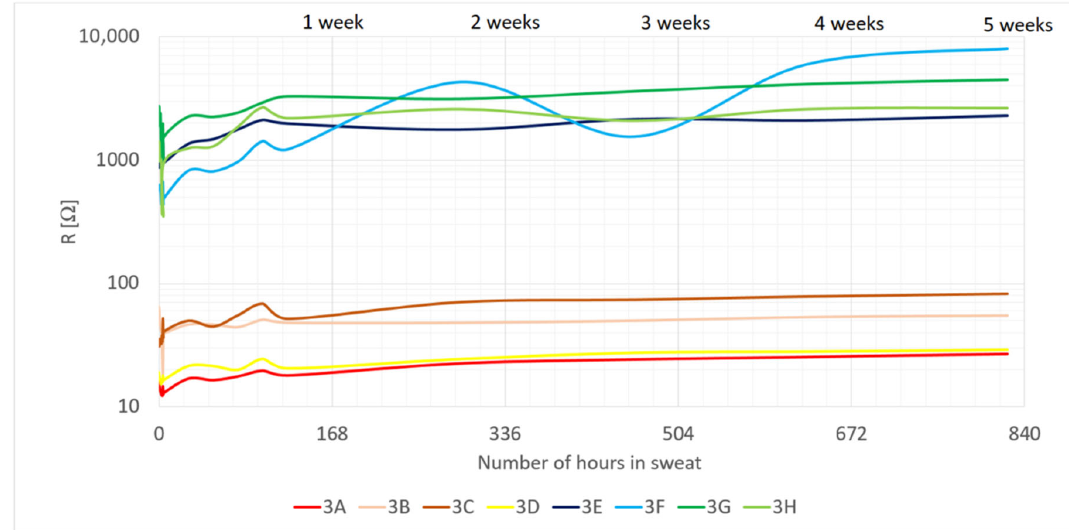
Figure 16. Medians of electrical resistance for the third sample type tested under sweat for samples 3A, 3B, 3C, 3D, 3E, 3F, 3G and 3H. The samples after the whole aging process (i.e., 823 h in sweat) were submitted for observations to find visual changes (see Figure 17). The degradation of conductive lines is clearly visible, with a higher intensity for samples aged in acidic sweat. However, encap ‐ sulation clearly fulfilled its purpose, and the joint under encapsulation was protected against sweat.